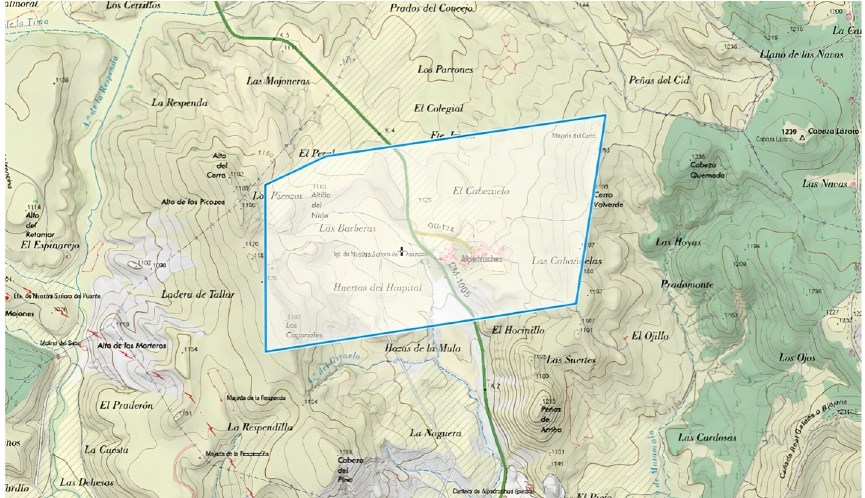
Figure 11. Location and extension of the testing location .